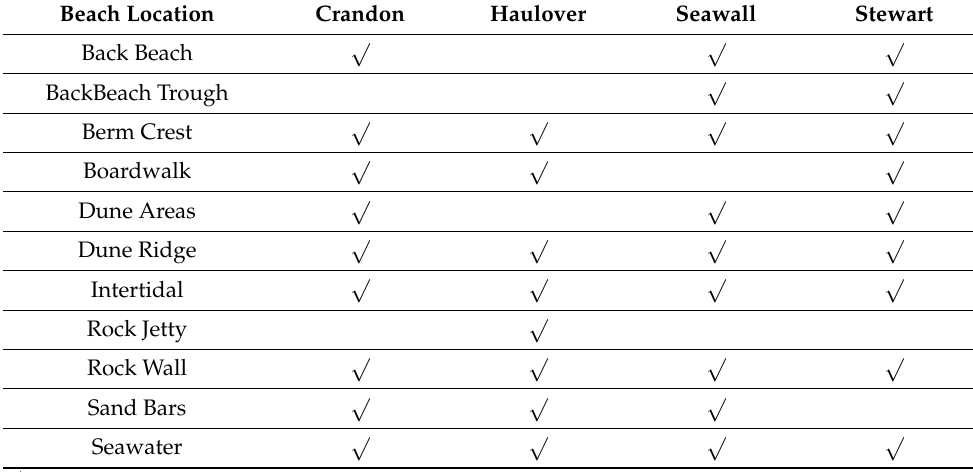
Table 2. Presence of Locations at